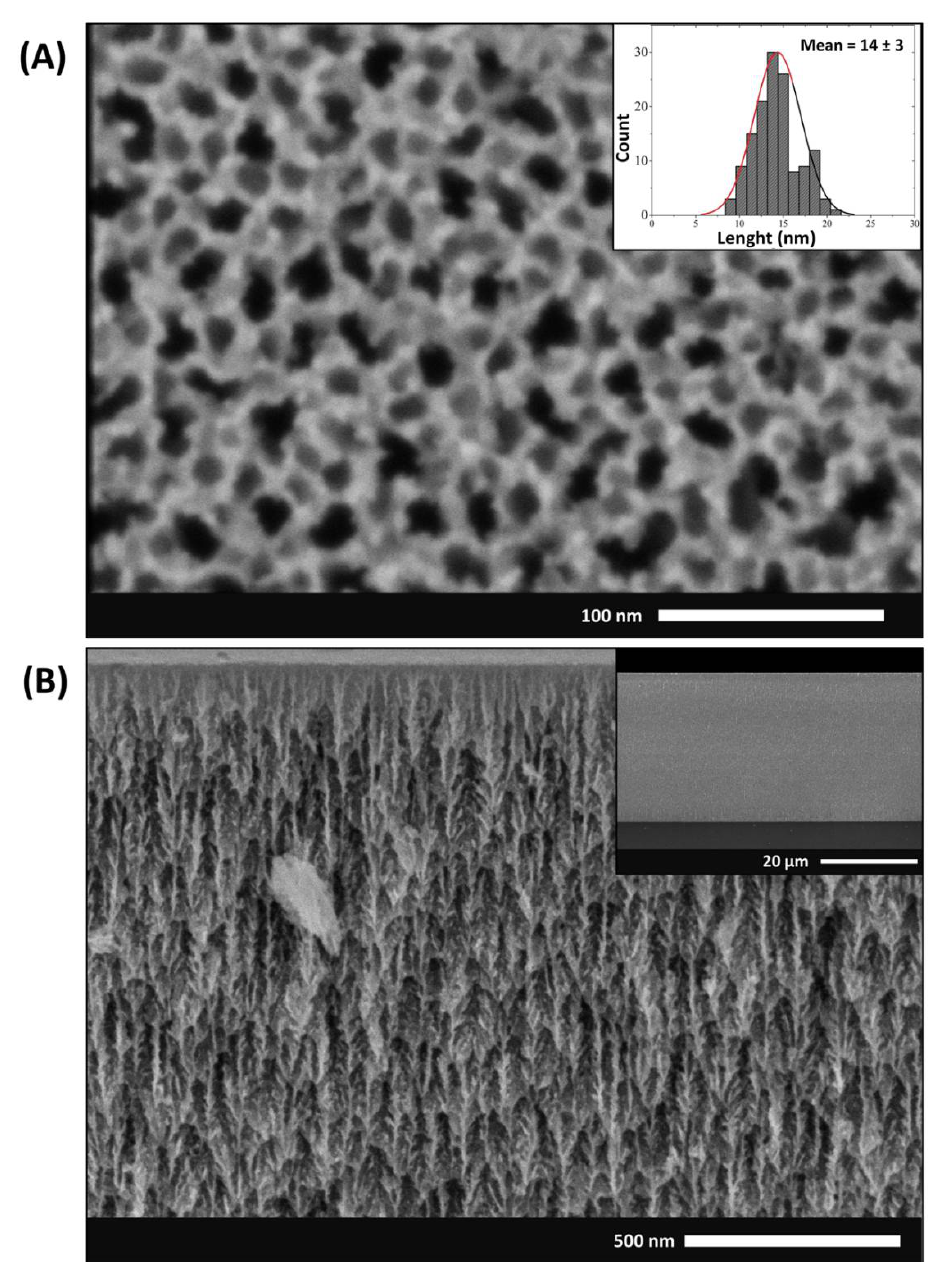
Figure 2. ( A ) FE-SEM image of the surface of the nPSi layer. Inset: distribution of pore size mea- surements. ( B ) Cross-section FE-SEM image of the nPSi layer. Inset: the same cross-section at lower magnification to see the total thickness of the thin